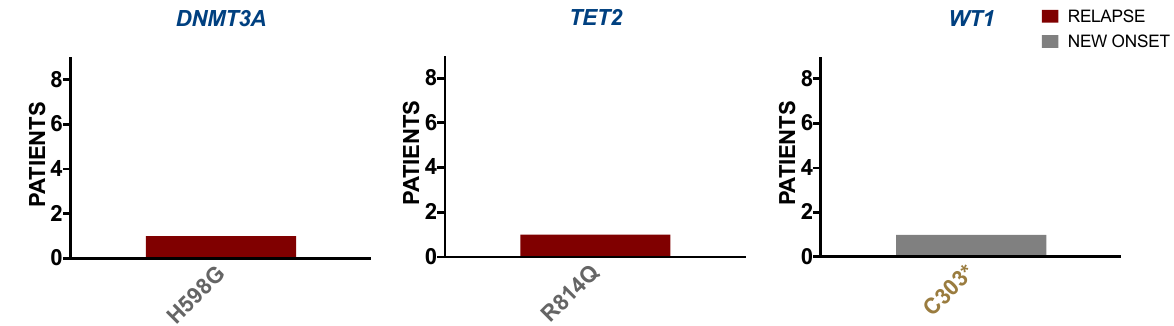
Figure 2. ALL borderland patients harbor tier mutations detected in second-level biomarkers with diagnostic and prognostic value for hematologic malignancies. Variants are shown occurring in new-onset (grey) and relapse (maroon) ALL patients where mutational significance is indicated by Tier X (grey) and Tier 3 (gold) within Level 2 clinically relevant genes (blue) including DNMT3A , TET2 , and WT1 involved in epigenetic regulation.